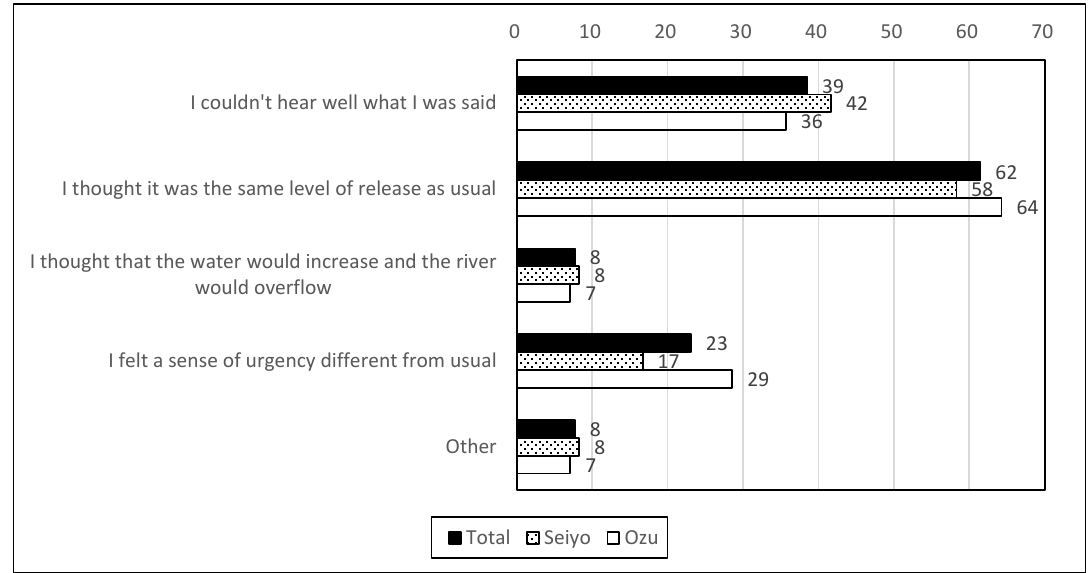
Figure 10. Feeling induced by the discharge warning (%), n = 26.